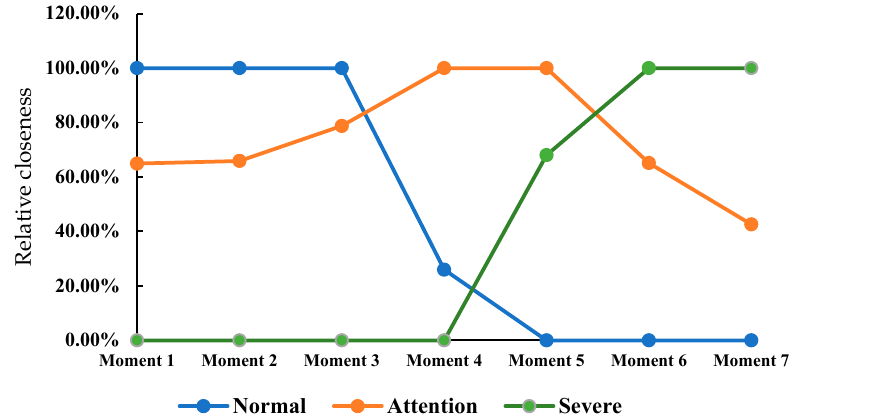
Figure 8. Change of characteristic weight at each moment.